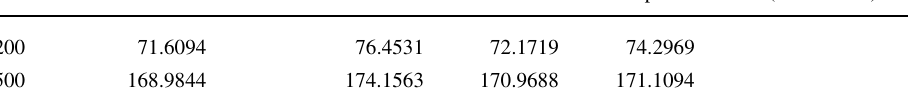
Table 8 Comparison of CPU time for conventional SOM, PLSOM2, and proposed RZA-SOM algorithms on handwritten character dataset